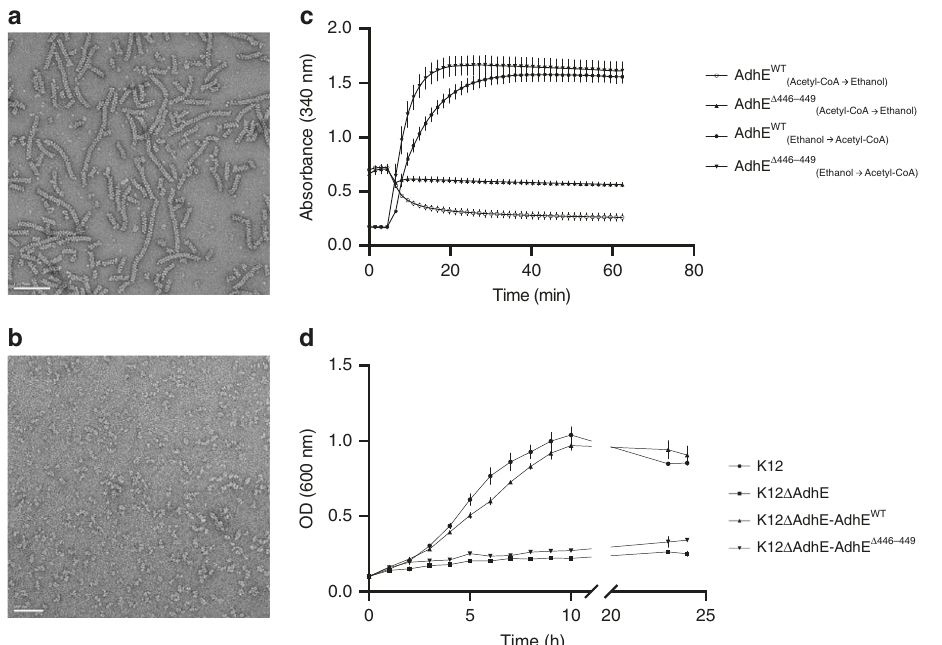
Fig. 6 Functional analysis of AdhE in vitro and in vivo. a Negative stain electron micrograph of puri fi ed Wild-Type AdhE fi laments. Scale bar 100 nm. b Negative stain electron micrograph of puri fi ed Δ 446 – 449 AdhE fi laments. Scale bar 50 nm. c Enzymatic assays monitoring AdhE activities of Wild-Type and Δ 446 – 449 mutant AdhE. The conditions of each assay are indicated in the legend of the graph. The errors bars show SEM (3). d Growth curves for K12 E. coli strains in fermentative conditions in minimal medium. The strains used are indicated in the legend of the graph. The errors bars show SEM